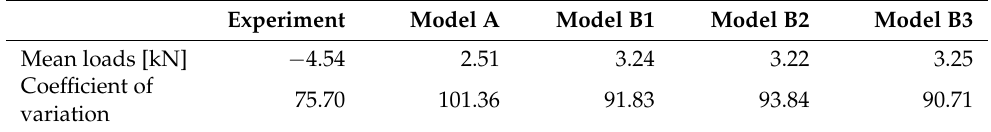
Table 5. Mean and Coefficient of Variation (CoV) values for tower base fore-aft shear.